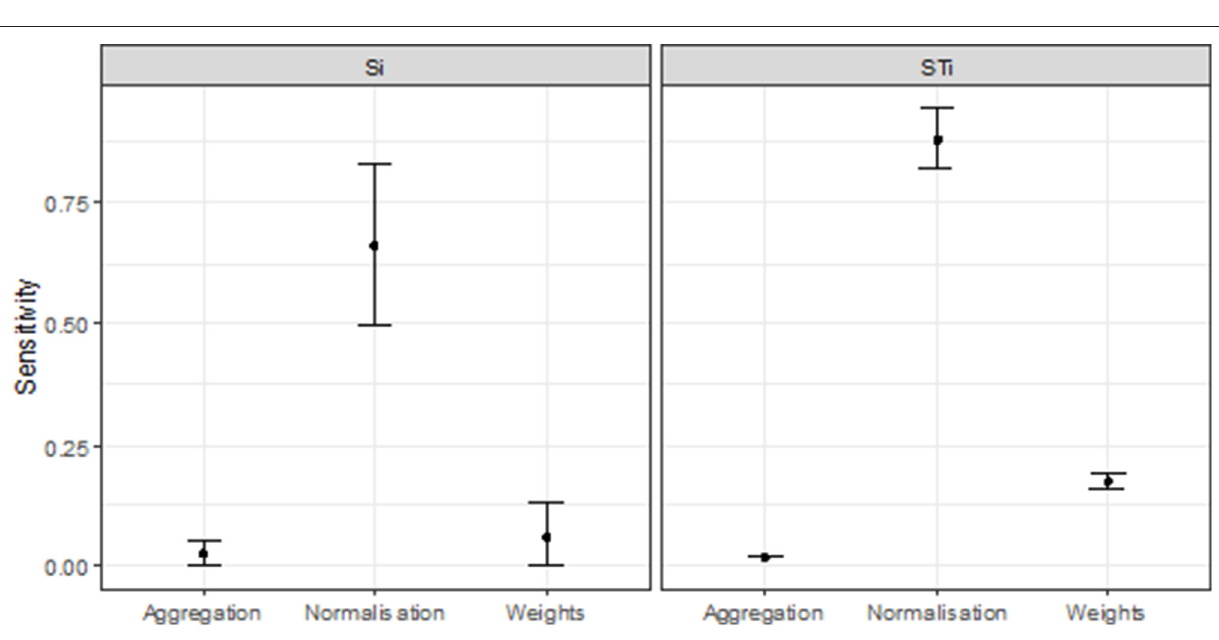
water and food pillars. A trade-off is that more energy will be